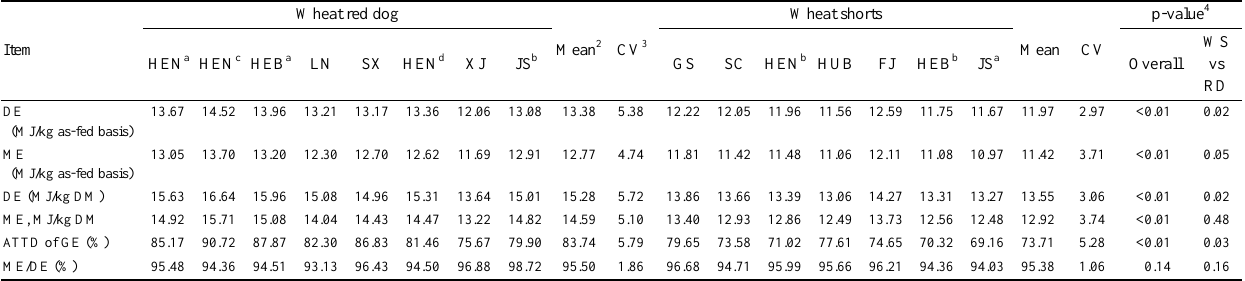
Table 4. Energy concentration and apparent total digestibility of energy of the wheat shorts and red dog for Exp. 1 1